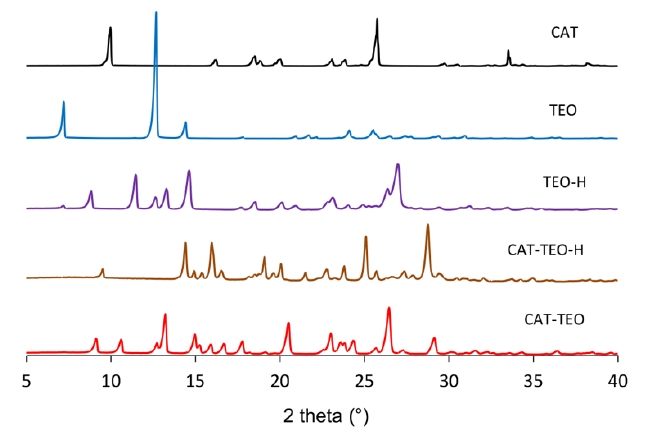
Figure 3. X-ray diffractograms showing the formation of a new solid phase belonging to CAT-TEO cocrystal. CAT (catechol); TEO (theophylline); TEO-H (theophylline ground with water); CAT-TEO-H (catechol and theophylline ground with water); CAT-TEO (catechol and theophylline ground with dichloromethane).